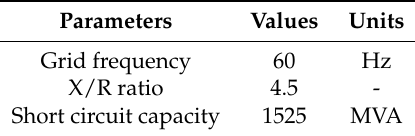
Table A1. Grid parameters.